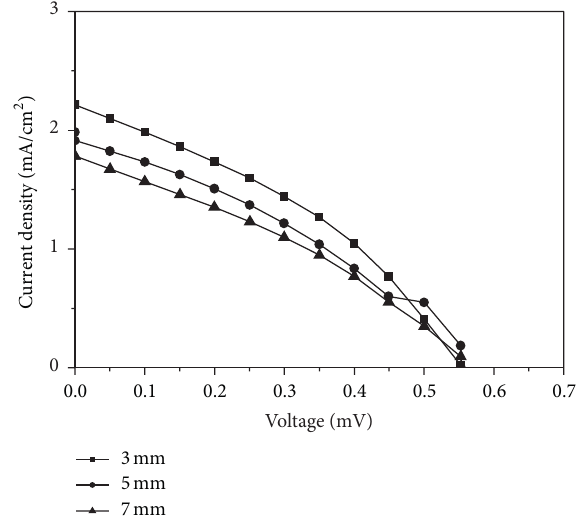
Figure 14: Photovoltaic curves ( J-V ) of the tandem DSSC prepared with a Pt counter